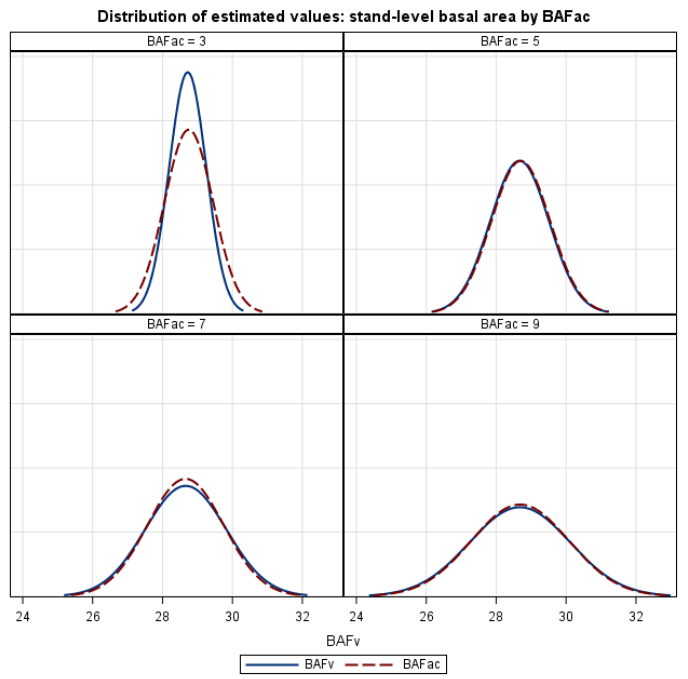
Figure 5. Employing the example from Brazil, the population value of the stand at age 12 for total basal area ( G ; m 2 · ha − 1 ) is equal to 28.8. Both estimators, namely BAF AC and BAF V , are unbiased for any basal area factor, however, the BAF V estimator is somewhat more precise when BAF AC < 4.